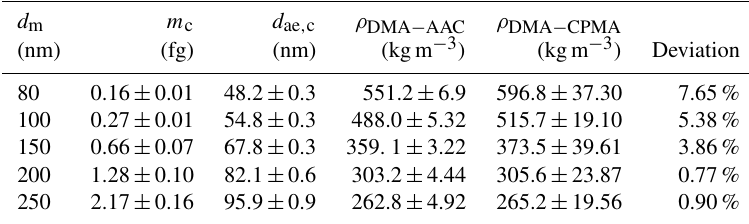
Table 2. Mobility diameter, mass, aerodynamic diameter, and effective densities calculated by DMA–AAC and DMA–CPMA and the devi- ation between them for fresh soot particles in the size range of 80–250nm. d